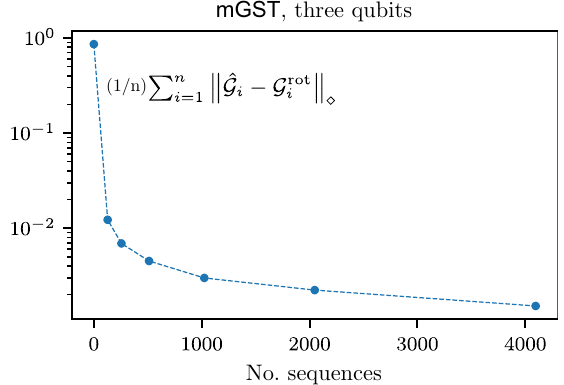
FIG. 4. Average diamond distance between three-qubit rotated and their unitary ( r K = 1) mGST estimators target gates G rot i ˆ G i as a function of the number of sequences. The 0-sequence data mark the average diamond distance between initialization G i and G rot . The rotated gates G rot are related to their counterparts i i G i by independent random (global) over-rotations on each gate, given by exp ( i γ H ) with H ∼ GUE and γ = 0.05, leading to √ E (cid:10) γ H (cid:10) ≤ 2 2 / 5. The data are simulated from the gates G rot ∞ with depolarizing noise of strength p = 0.01 on each gate and the measurements are taken from random sequences of length (cid:2) = 7, with m = 10 5 samples per